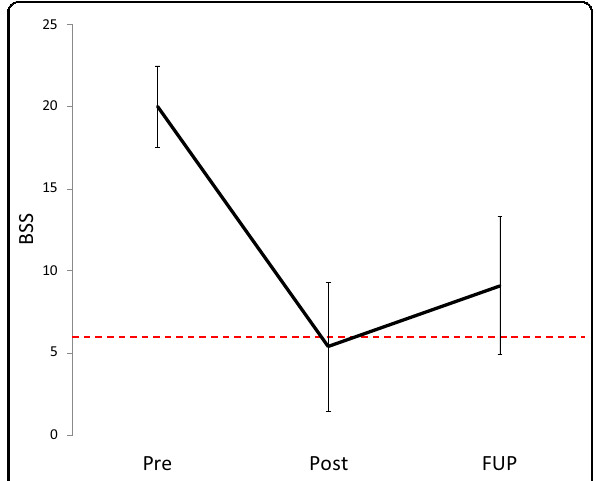
Fig. 2 Mean Beck Scale for Suicidal Ideation (BSS) scores across three key timepoints. “ Pre ” = pre-ketamine, “ Post ” = post-ketamine, “ FUP ” = follow-up; dashed red line denotes cut-off (BSS ⩽ 6) for clinically signi fi cant suicidal ideation; error bars denote 99%